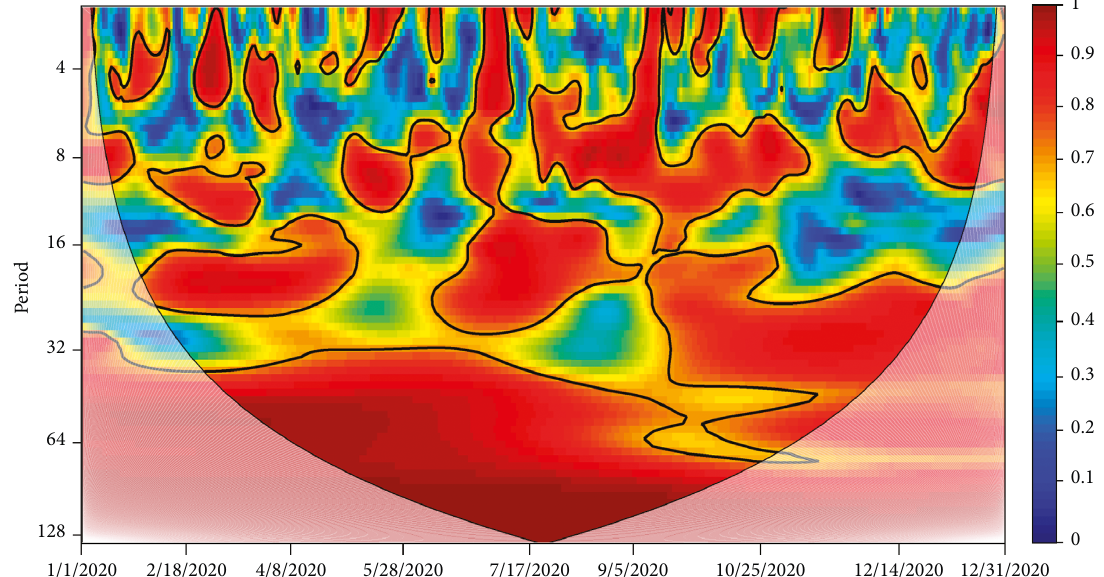
Figure 9: The combined effects of EPU and VIX on illiquidity (pandemic period).Note: this figure reports the combined effects of EPU and VIX on illiquidity during pandemic period. The black contour represents the regions in which the spectrum is significant at the 5% level against red noise. The cone of influence denoted as COI is designated by the lighter shade which delineates the high power regions. Time and scale (days) are represented on the horizontal and vertical axes, respectively. Arrows pointed to the right (resp. left) signify that the variables are in phase (out of phase). If arrows move to the right and up (resp. down), the first variable is the driver (resp. follower). By contrast, if arrows move to the left and up (down), the second variable is leading (resp.